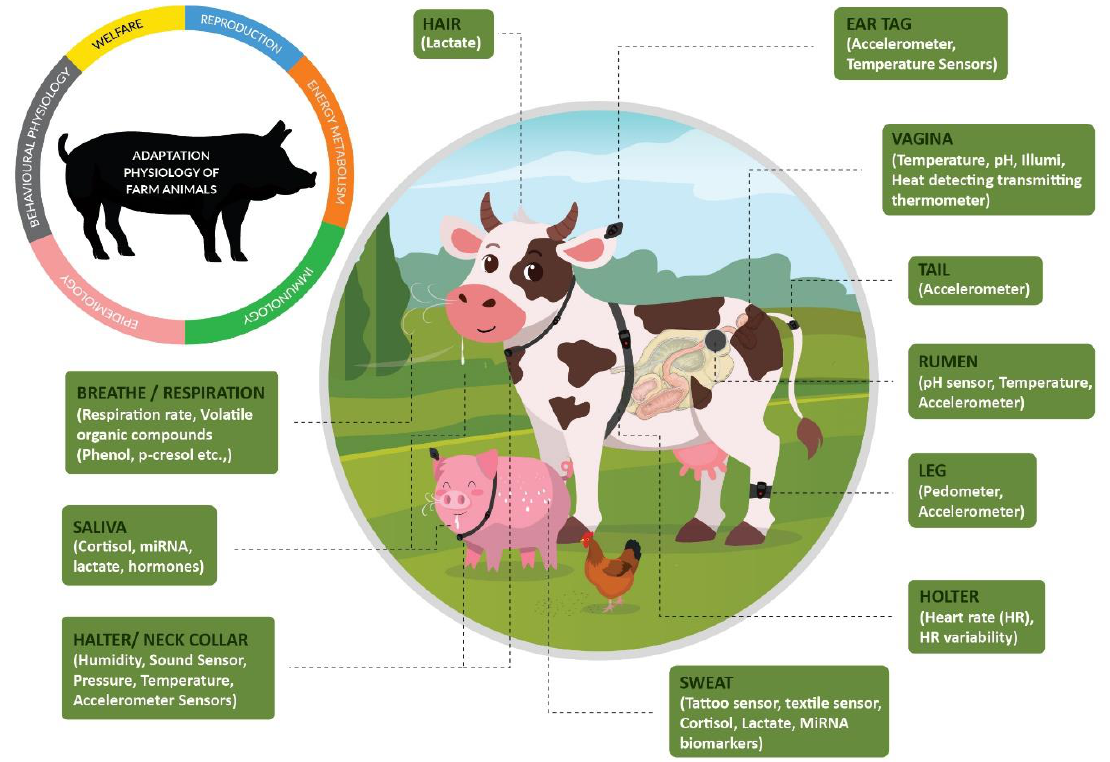
Figure 1. Wearable sensors and novel biomarkers for transforming the adaptation physiology of farm animals.